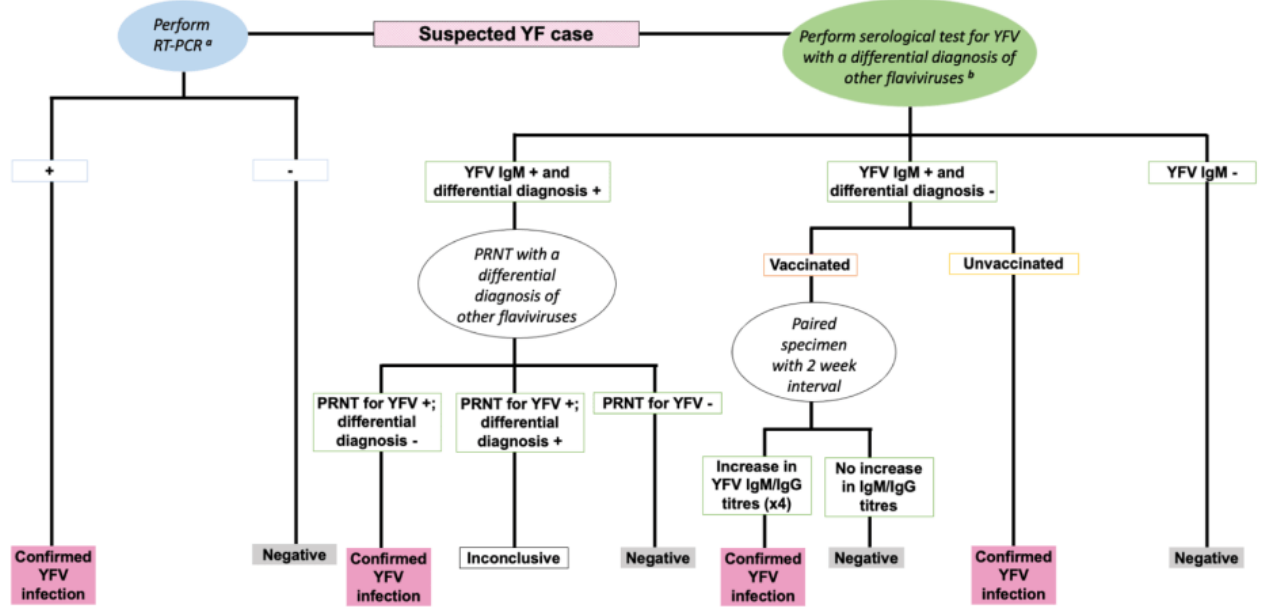
Figure 4. An algorithm for the diagnosis of YFV infection [23]. RT-PCR: Reverse Transcriptase Polymerase Chain Reaction. IgM: Immunoglobulin M. IgG: Immunoglobulin G. +: Positive. -: Negative. a RT-PCR performed on samples collected within less than 10 days of symptom onset. b Differential diagnosis of other flaviviruses such as DENV, WNV, ZIKV.